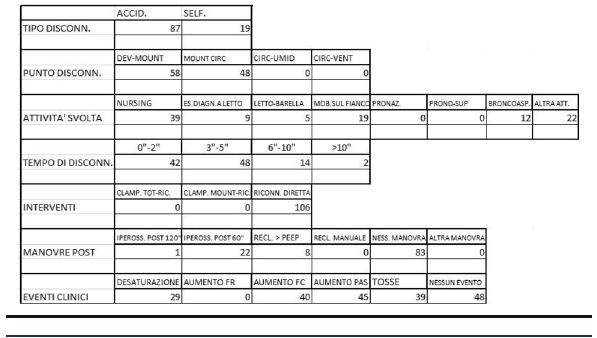
A35. Fascial plane blocks for intra and post operative analgesia after breast augmentation vs general anesthesia: a randomized clinical